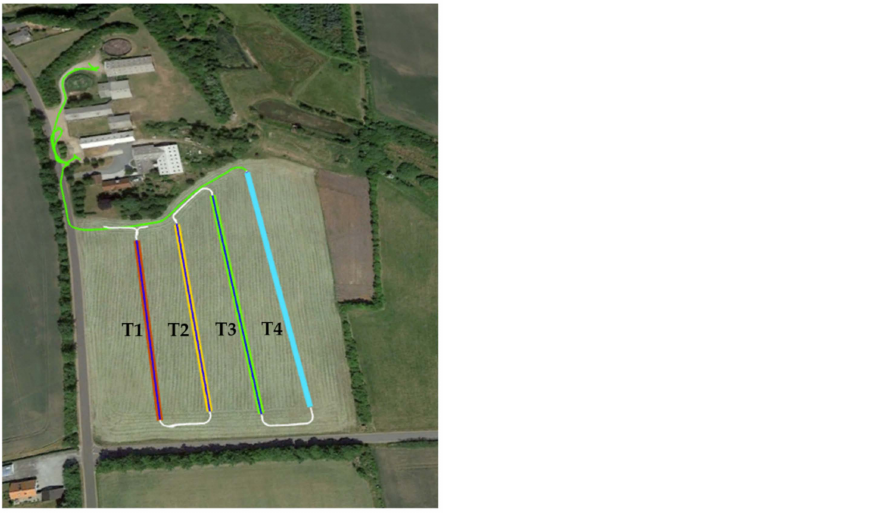
Figure 6. The sample field was used for the draft force test. T1, . . . , T4 represent the field work tracks. The draft force (N) required to pull the implementation (in the horizontal direction) can be estimated based on Equation (7). The soil and machine parameters for the weeder and seeder were presented in Table 3.